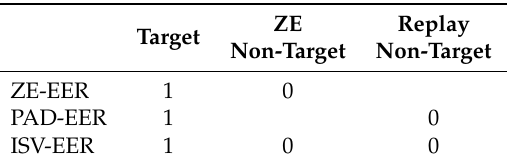
Table 2. Three types of EERs reported in this paper: Enrollment utterance is always bona fide (i.e., genuine, not replayed). Target: enrollment and test utterances are uttered by an identical speaker and are bona fide; zero-effort (ZE) non-target: enrollment and test utterances are uttered by different speakers and are bona fide; Replay non-target: enrollment and test utterances are uttered by an identical speaker and test utterance is replay spoofed.